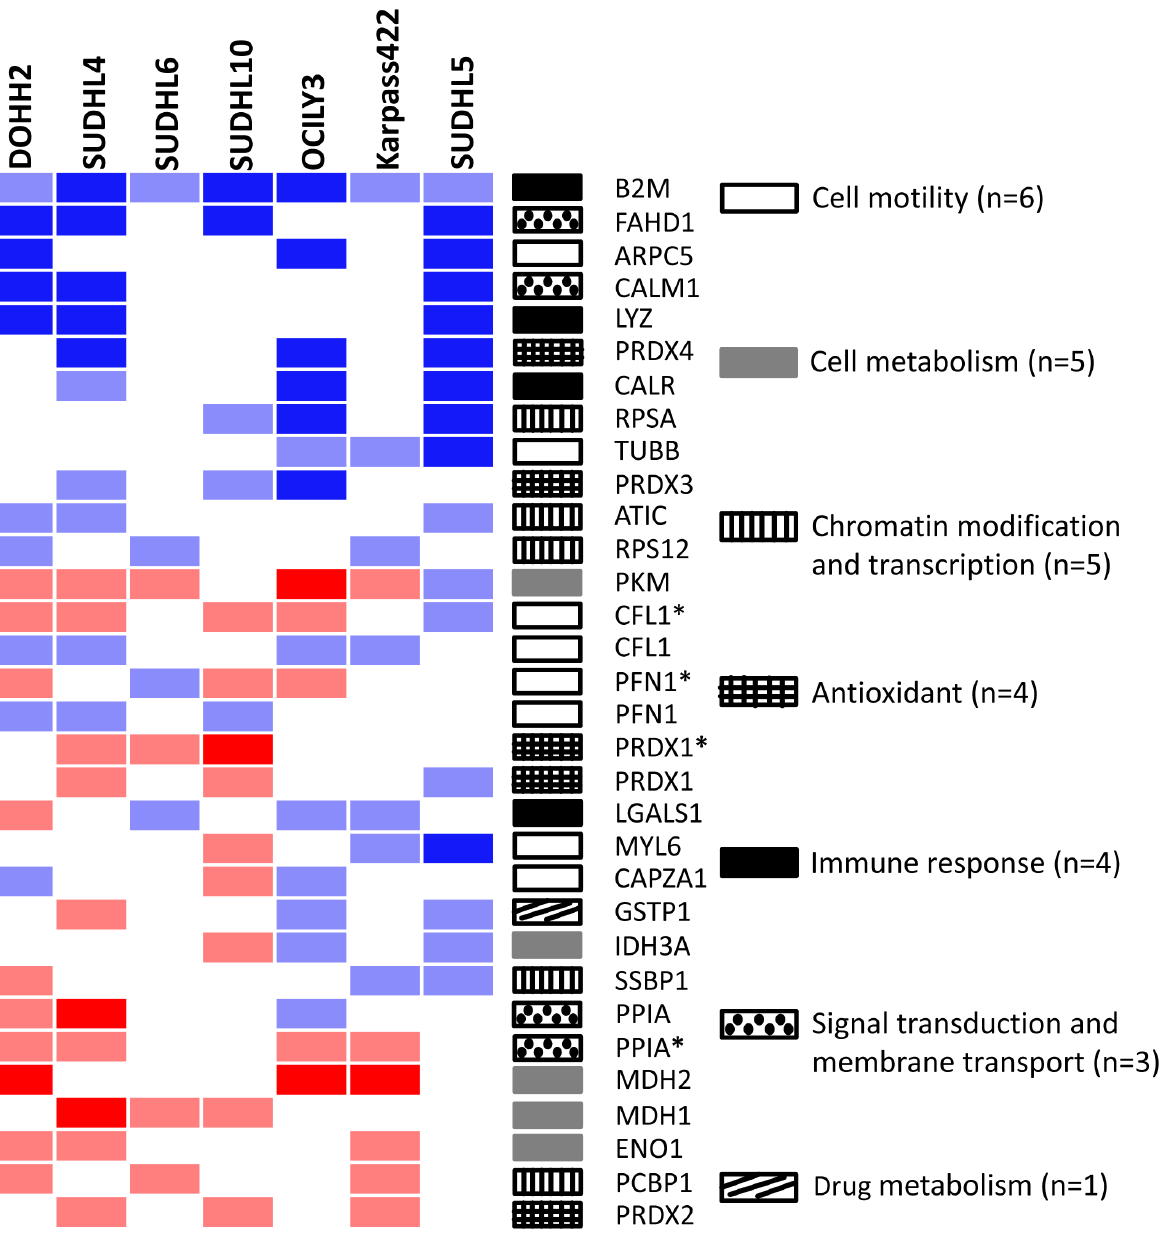
Fig 1. Heatmap of 2-D spots with different intensities in NHL compared with the LCL cell line. Proteins that were differentially expressed in at least 3 cell lines are shown. In total, 28 different proteins have been found and 4 proteins were also found in a modified form ( * ). Blue: protein spot is missing in NHL cell lines. Light blue: protein spot is down-regulated in NHL cell lines. Red: protein spot is missing in LCLs and thus increased in NHL cell lines. Light red: Protein spot is weaker in LCL and thus elevated in NHL cell lines. Gene ontology was checked to classify the proteins according to function.